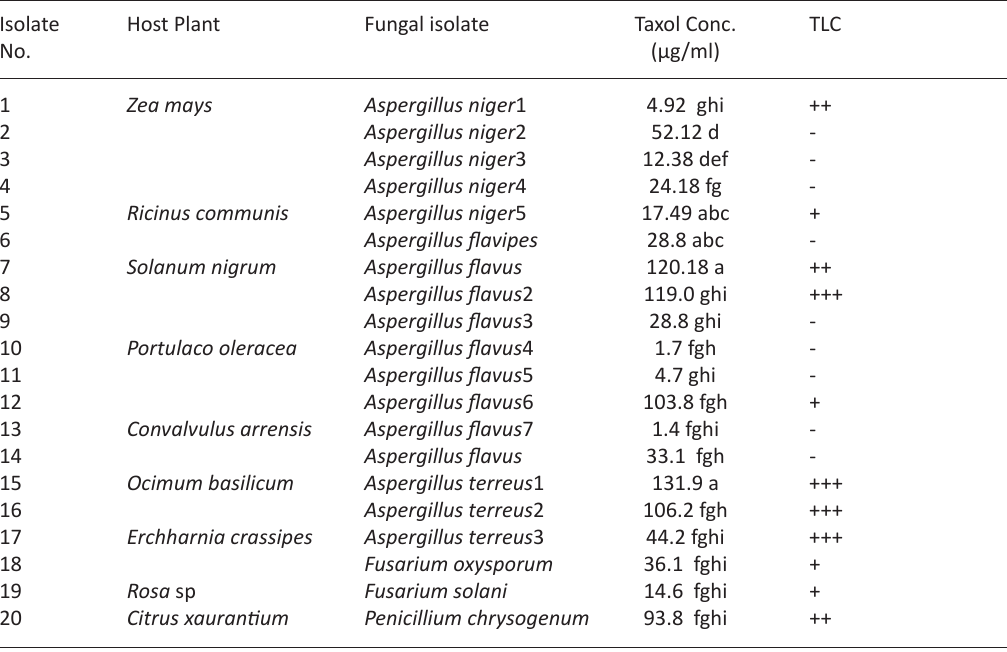
Table 1. Spectroscopic and chromatographic analyses of the twenty fungal isolates Isolate Host Plant Fungal